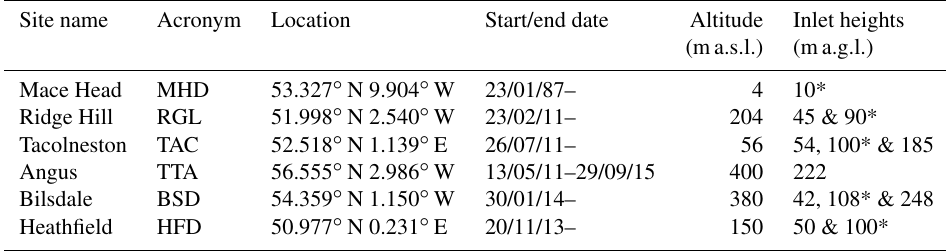
Table 1. The name, location, and inlet heights of the UK tall-tower network. Entries denoted by an asterisk denote an intake used by a GC–multidetector and, if present at site, by a Medusa gas chromatograph–mass spectrometer (GC-MS).